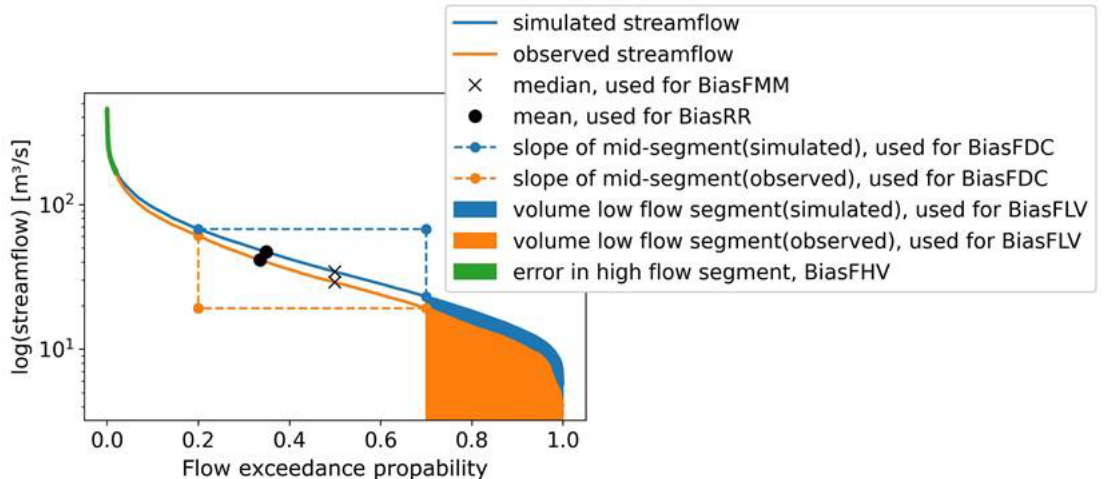
Figure 4. Two exemplary flow duration curves with highlighted features to explain the signature indices after Casper et al. [53].